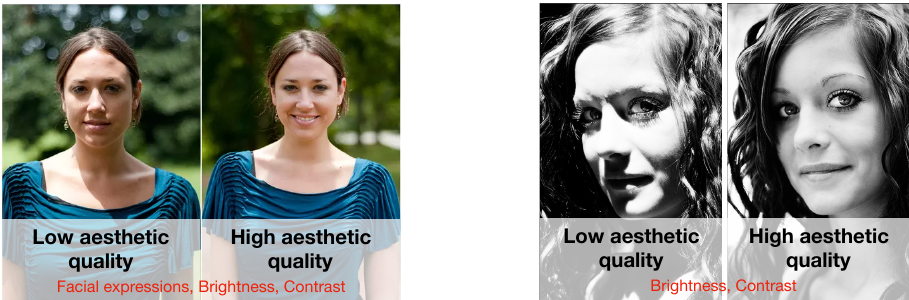
Figure 1. Face aesthetics represents the attractiveness of the photo shot. This takes into account aspects such as: facial expressions, brightness, contrast,